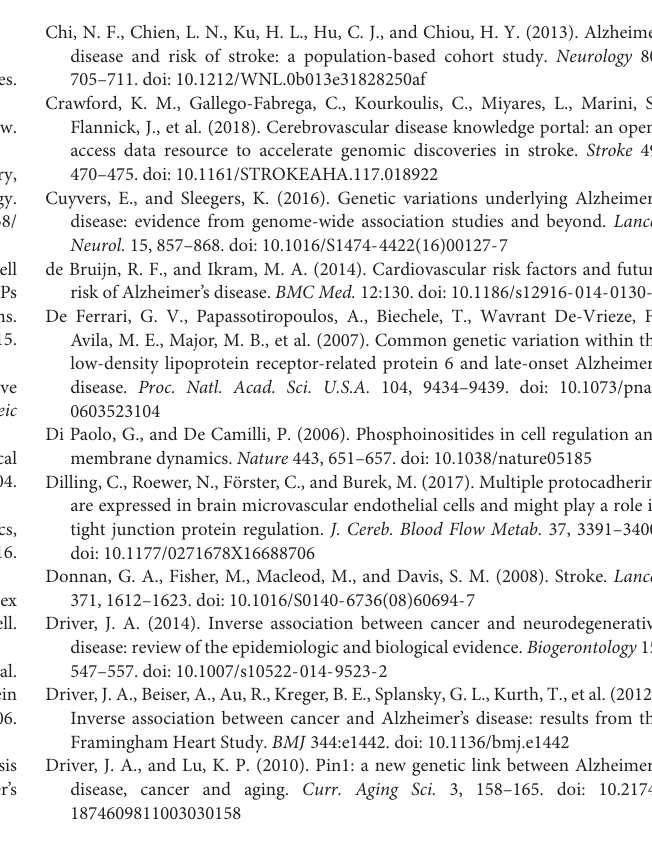
TABLE S1 | Gene-based testing results for the GWAS datasets of AD and IS. TABLE S2 | GO annotation results shared by AD and